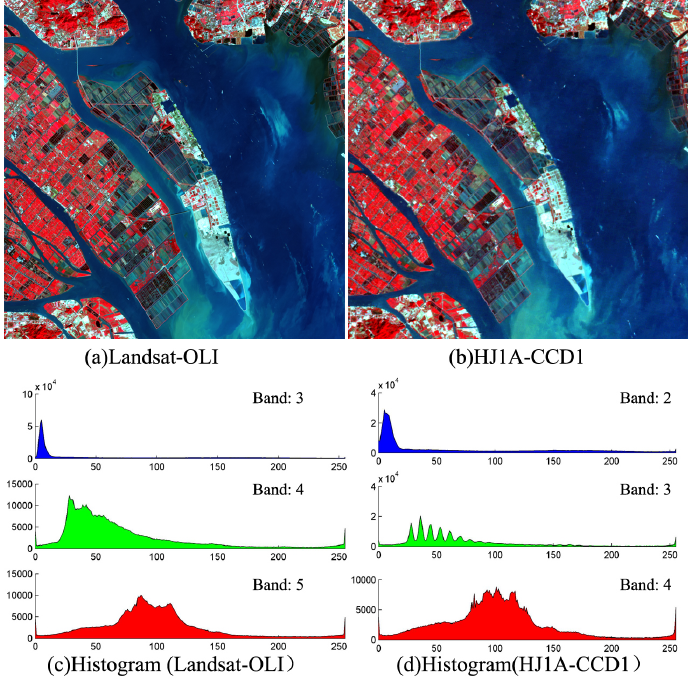
Figure 5. Reflectance images and histogram graphs of the original remote sensing